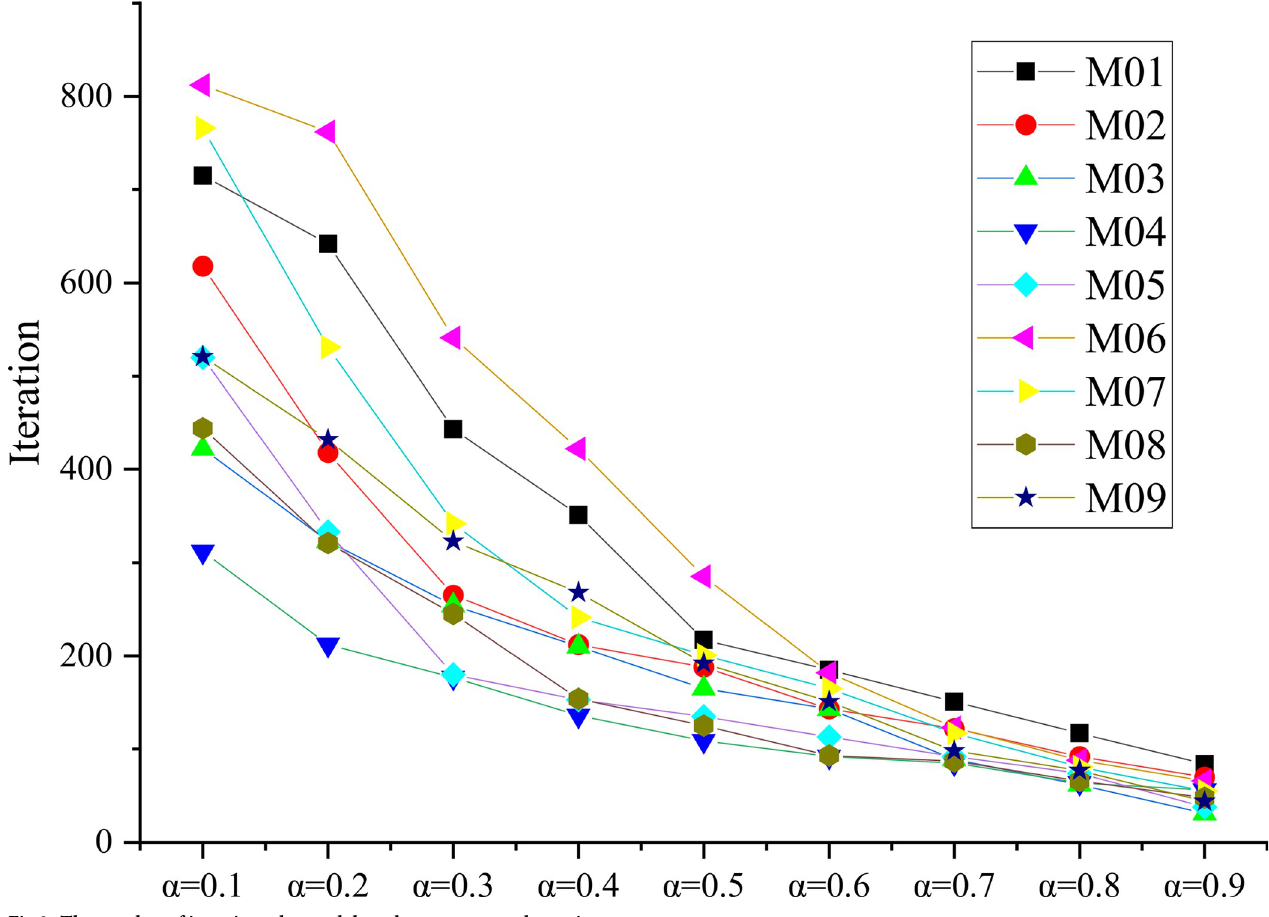
Fig 2. The number of iterations that path length converges to the optimum.